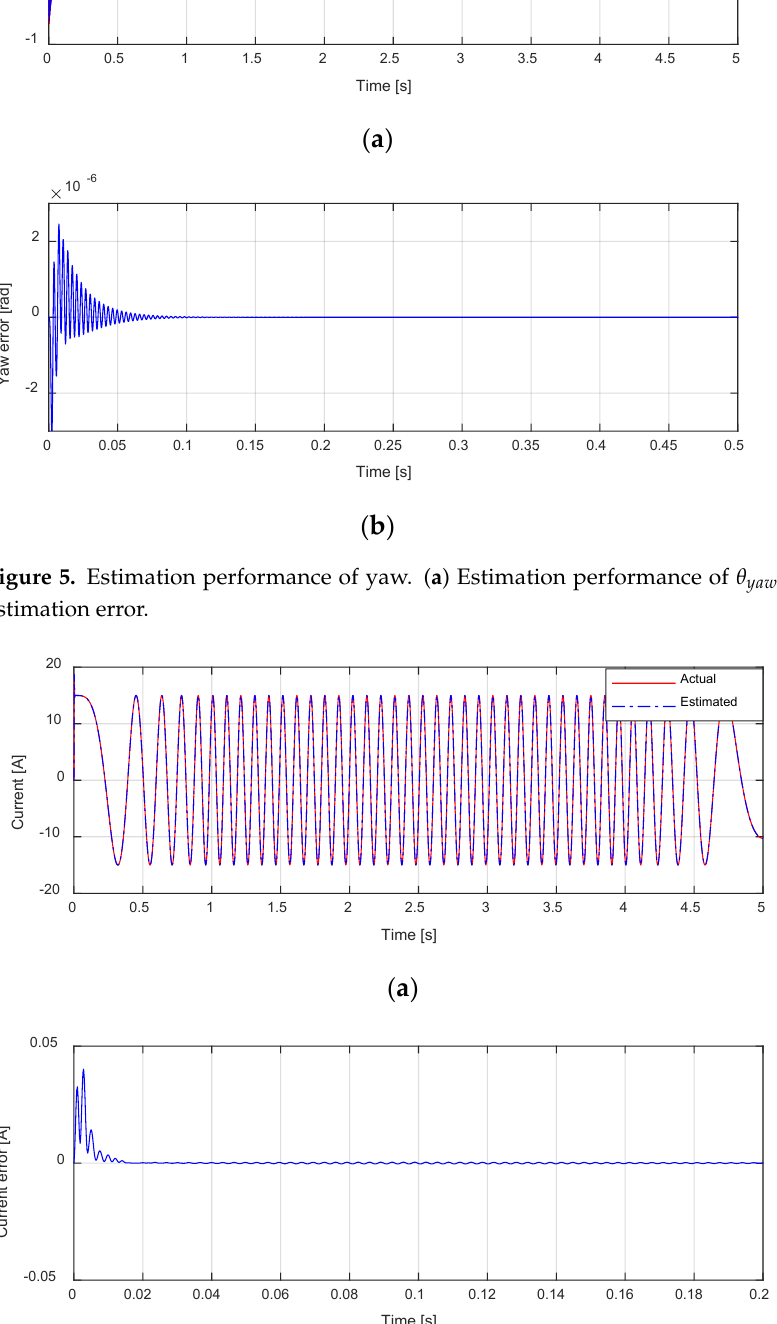
Figure 6. Estimation performance of phase A current. ( a ) Phase current estimation performance in phase A. ( b ) Phase current estimation error in phase A.